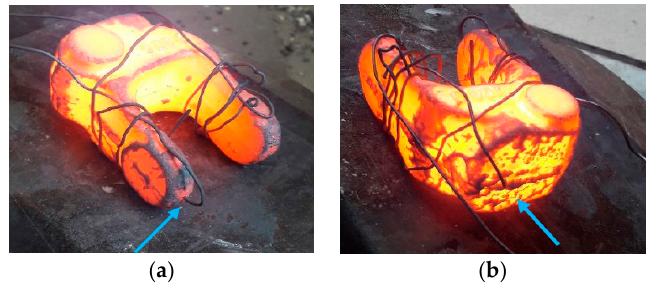
Figure 15. The forgings with the place of the thermocouples assembly marked on the prototype controlled cooling line: ( a ) in the fork and ( b ) in the body of